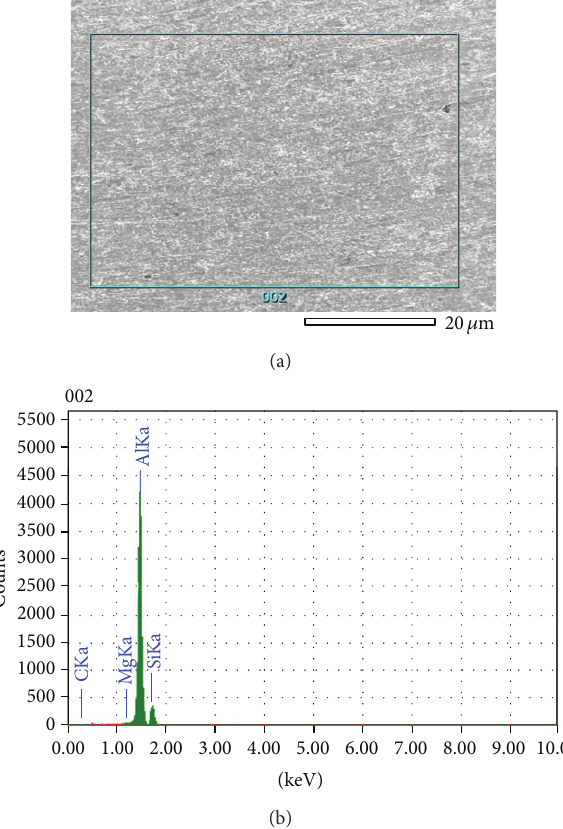
Figure 14: (a) Surface of the Al-7.5wt.% Gr composite before wear testing. (b) EDS spectrum of MML of the Al-7.5wt.% Gr composite before wear